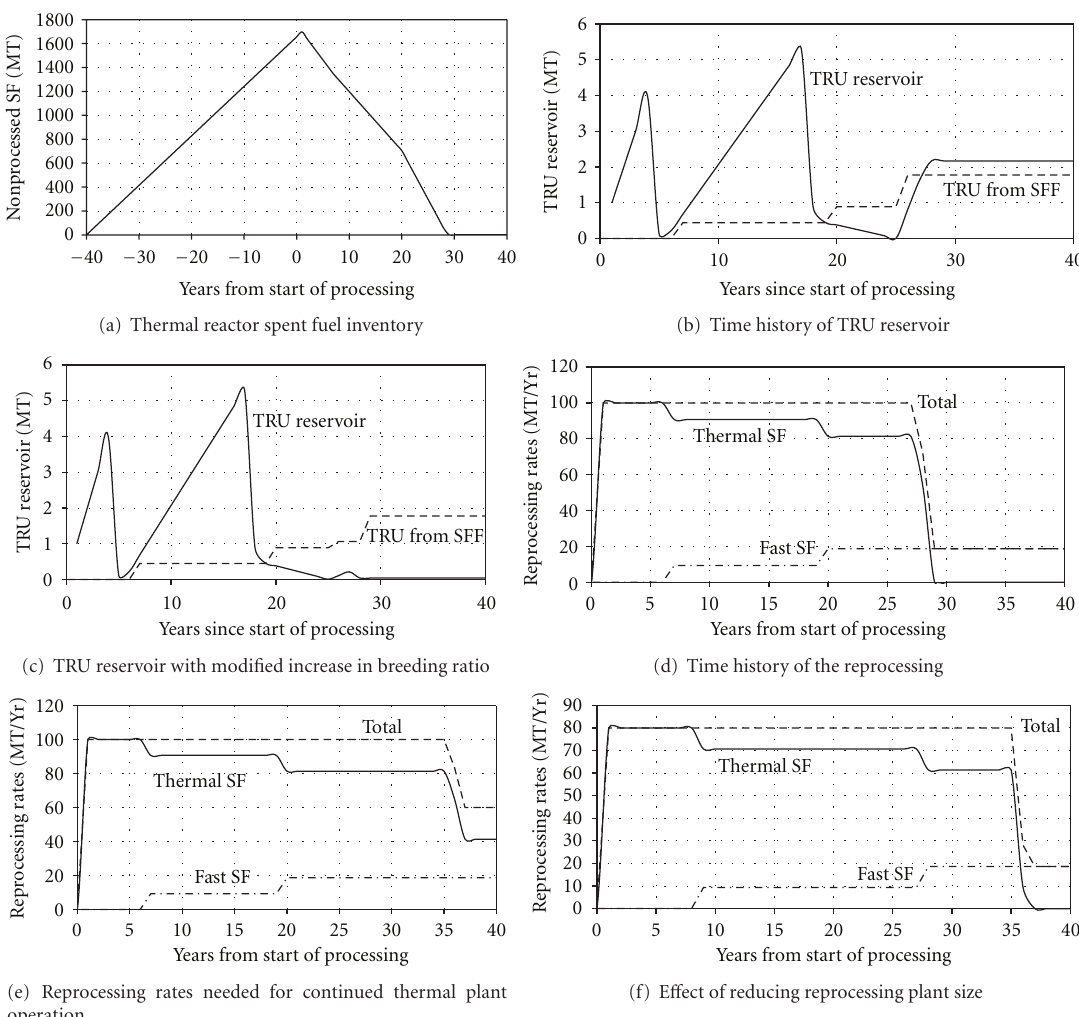
Figure 1: Site conversion from two thermal to two fast spectrum plants (BR =